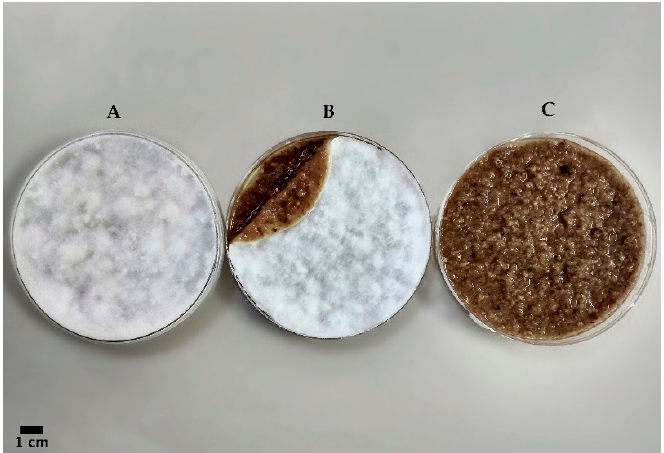
Figure 1. Fresh mycelial mat of Fomes fomentarius (8) obtained through patented method after 3 weeks growth in Petri plates: ( A ) the Petri after the 3-week growing phase; ( B ) a Petri where the removable mycelium mat that regrows on top of the slurry is visible; and ( C ) the remaining substrate after the removal of the mycelium mat.